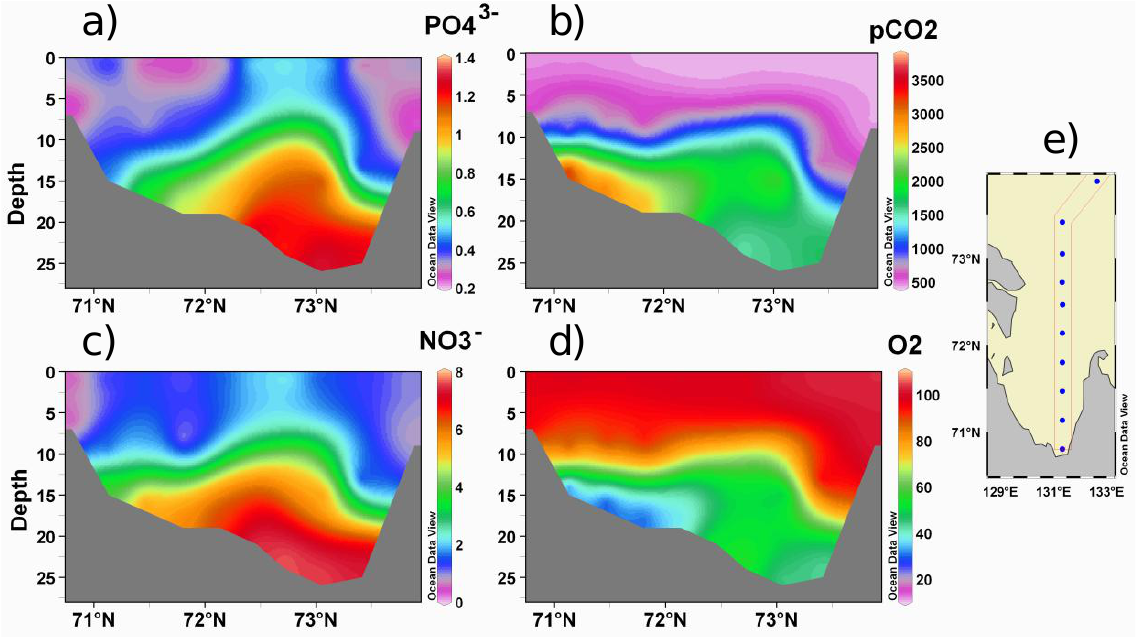
Fig. 14. Vertical distribution of phosphates (PO 3 − saturation state (O 2 , %) (d) in the water column observed in the Buor-Khaya Bay in summer 2005. Transect position is shown in (e) .